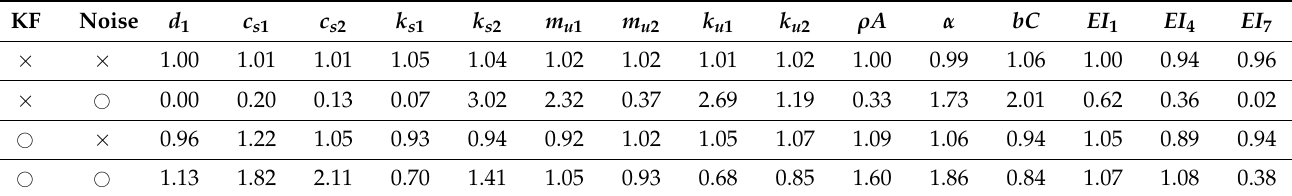
Table 4. Variance–Covariance Matrix Settings.